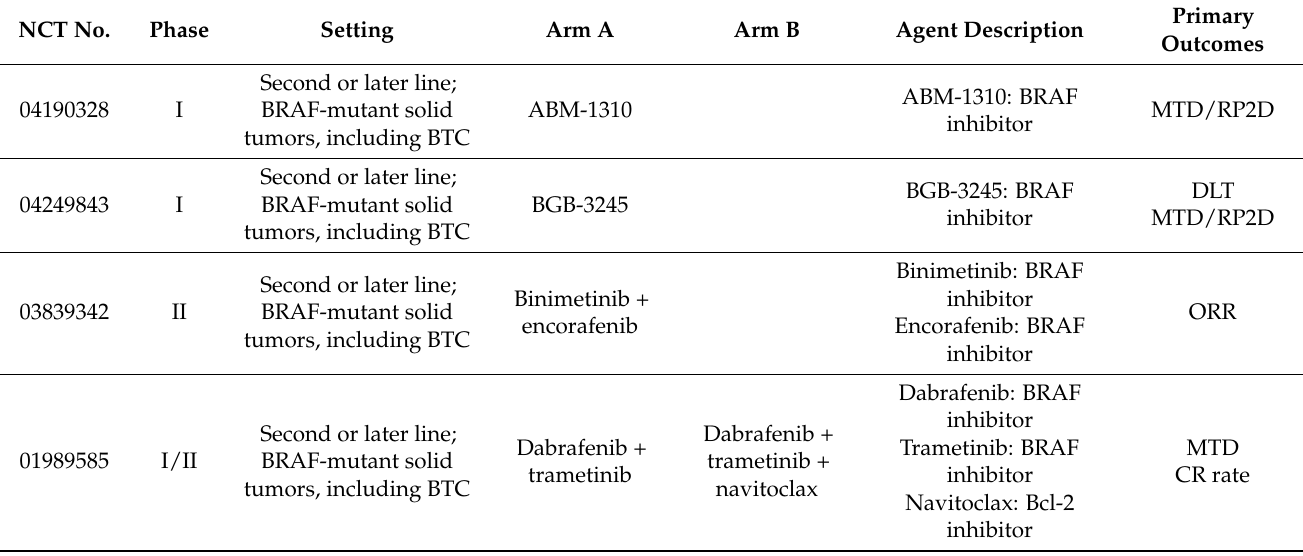
Table 4. Ongoing trials evaluating BRAF targeted therapies in advanced biliary tract cancer registered on ClinicalTrials.gov, accessed on 21 September 2021 [65]. NCT